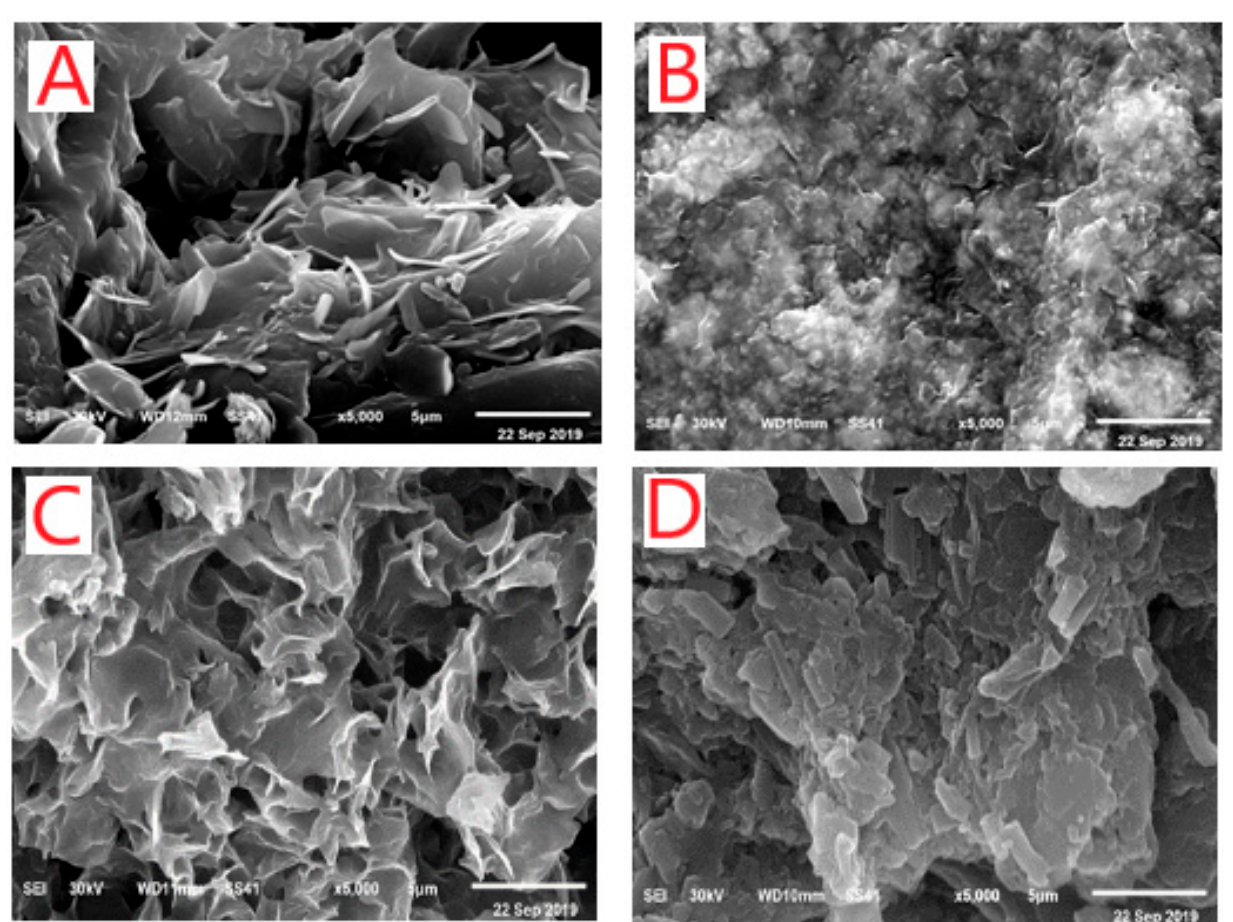
Figure 3. SEM images of ( A ) Mg(II), ( B ) Zn(II), ( C ) Cu(II), and ( D ) Se(IV) STG complexes.